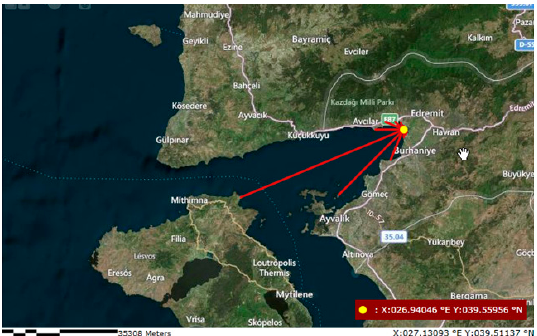
Figure 4. Fetch distances according to directions [33].